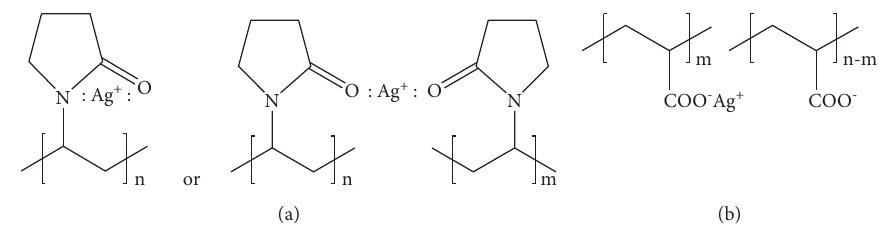
Figure 6: Scheme of formation of complexes of Ag(+) ions with PVP (a) or PA − (b).